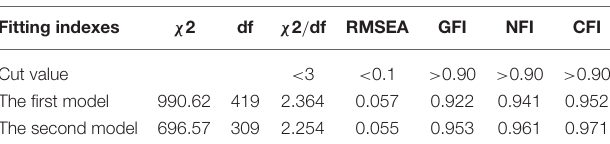
TABLE 4 | Model fit